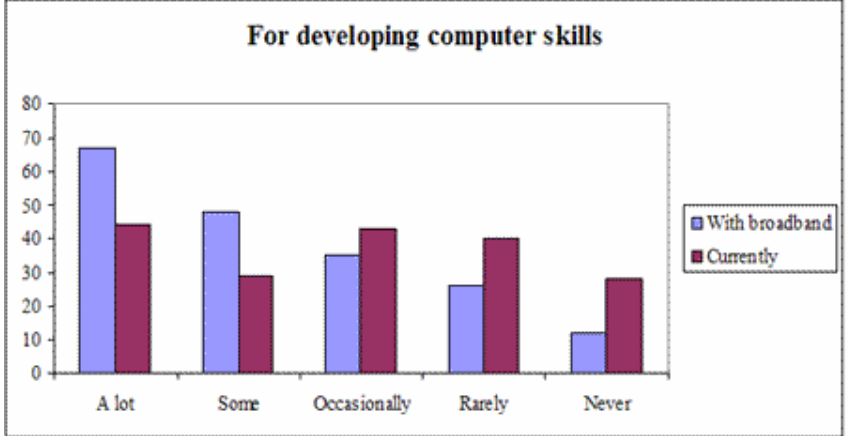
Figure 4. Respondents’ Current and Anticipated Use of the Internet for Developing Computer